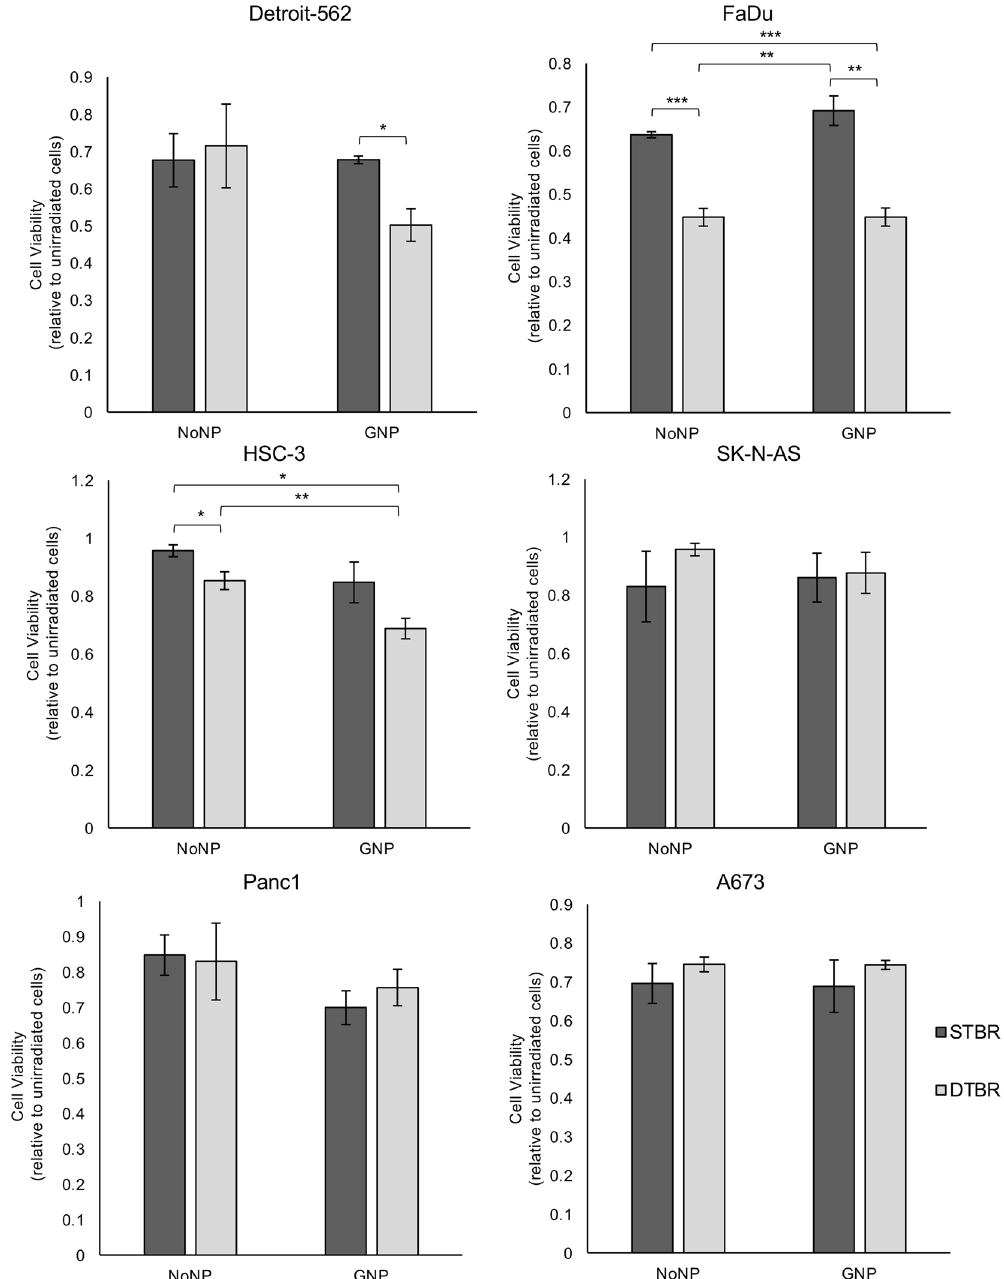
Figure 2. GNP-labeled HNCCs irradiated with the DTB show reduced viability 3 days post-irradiation. The alamarBlue viability assay was used to determine the levels of oxidative phosphorylation in cells irradiated with the STB or DTB and labelled with GNPs or NoNPs, 3 days after radiation. Detroit-562, FaDu, and HSC-3 HNCC lines demonstrated a significant reduction in cell viability following 8 Gy irradiation with the DTB in cells labelled with GNP compared to NoNP-labelled cells with STBR (p = 0.018, p = 0.004, p = 0.003, respectively). NoNP FaDu cells irradiated with the DTB demonstrated decreased viability compared to NoNP and GNP cells with STBR (p = 0.001 and p = 0.003, respectively). Similarly, NoNP HSC-3 cells irradiated with the DTB demonstrated a reduction in viability compared to NoNP cells with STBR (p = 0.049). With DTBR, GNP-labelled HSC-3 cells decreased compared to NoNP cells (p = 0.024). SK-N-AS cells, Panc1 cells, and A673 cells demonstrated no significant differences in viability. Cell viability values are made relative to control cells that were not irradiated and are presented as the fold change means ± standard error of the mean, p* < 0.05, p** < 0.01, p*** < 0.001 for significant decrease in cell viability. Significance between groups was tested using one- way analysis of variance (ANOVA) with a Tukey multiple comparisons test (n = 3; 10 wells per group/replicate). GNP gold nanoparticles, NoNP no nanoparticles, HNCC head and neck cancer cells, STB(R) standard target beam (radiation), DTB(R) diamond target beam